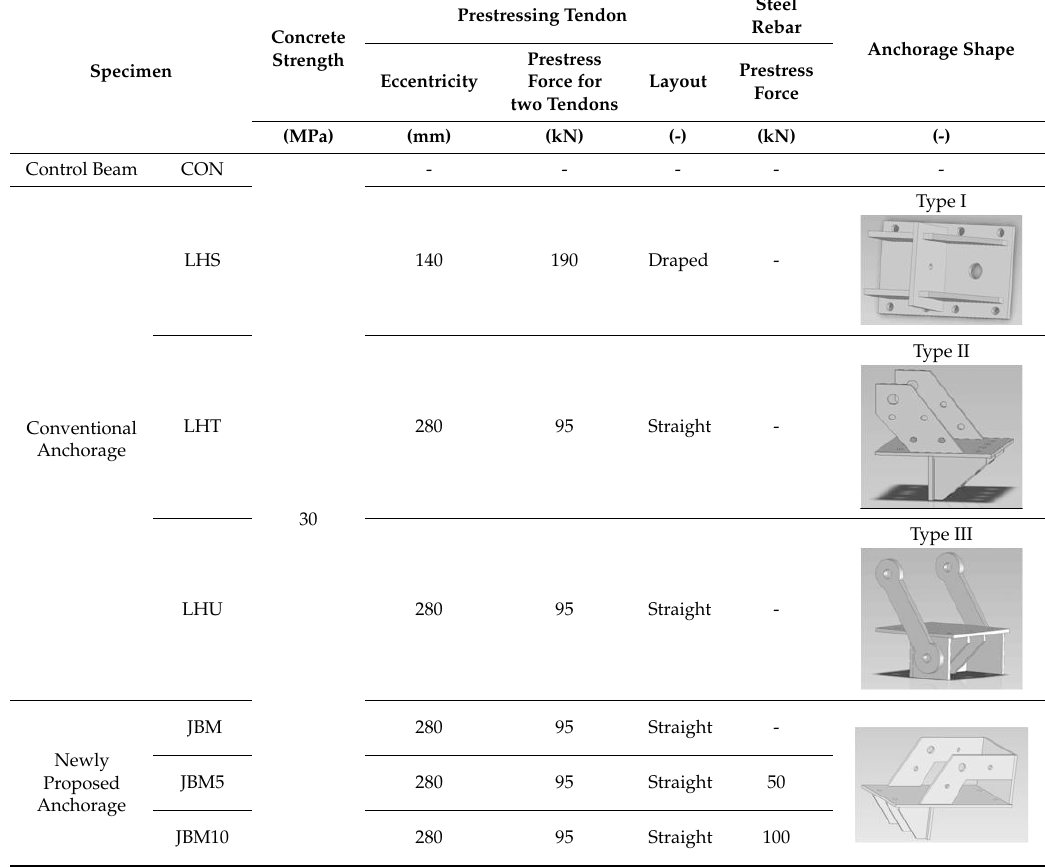
Table 1. Variables for tested beams. CON: the control beam; LHS: the beam applied with the conventional anchorage Type I; LHT: the beam applied with the conventional anchorage Type II; LHU: the beam applied with the conventional anchorage Type III; JBM, JBM5, JBM10: the beams applied with the newly proposed anchorage as well as used 0, 5 and 10 kN prestressed steel rebars. Concrete Strength Specimen